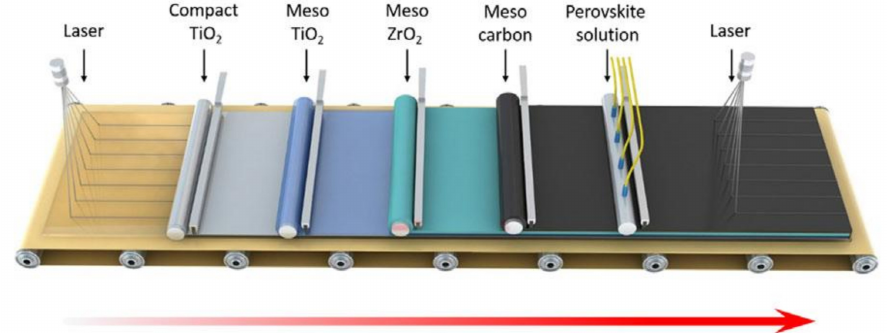
Figure 4. Schematic illustration of the proposed production line of large-scaled perovskite solar cells. Reprinted from Yue Hu et al., (2017), [67] Copyright (2017), with permission from WILEY-VCH Verlag GmbH & Co. KGaA, Weinheim.